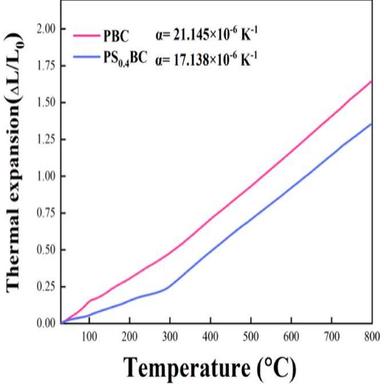
Thermal expansion curve in air atmosphere test for PBC and PS0.4BC samples at 30–800 ◦C.